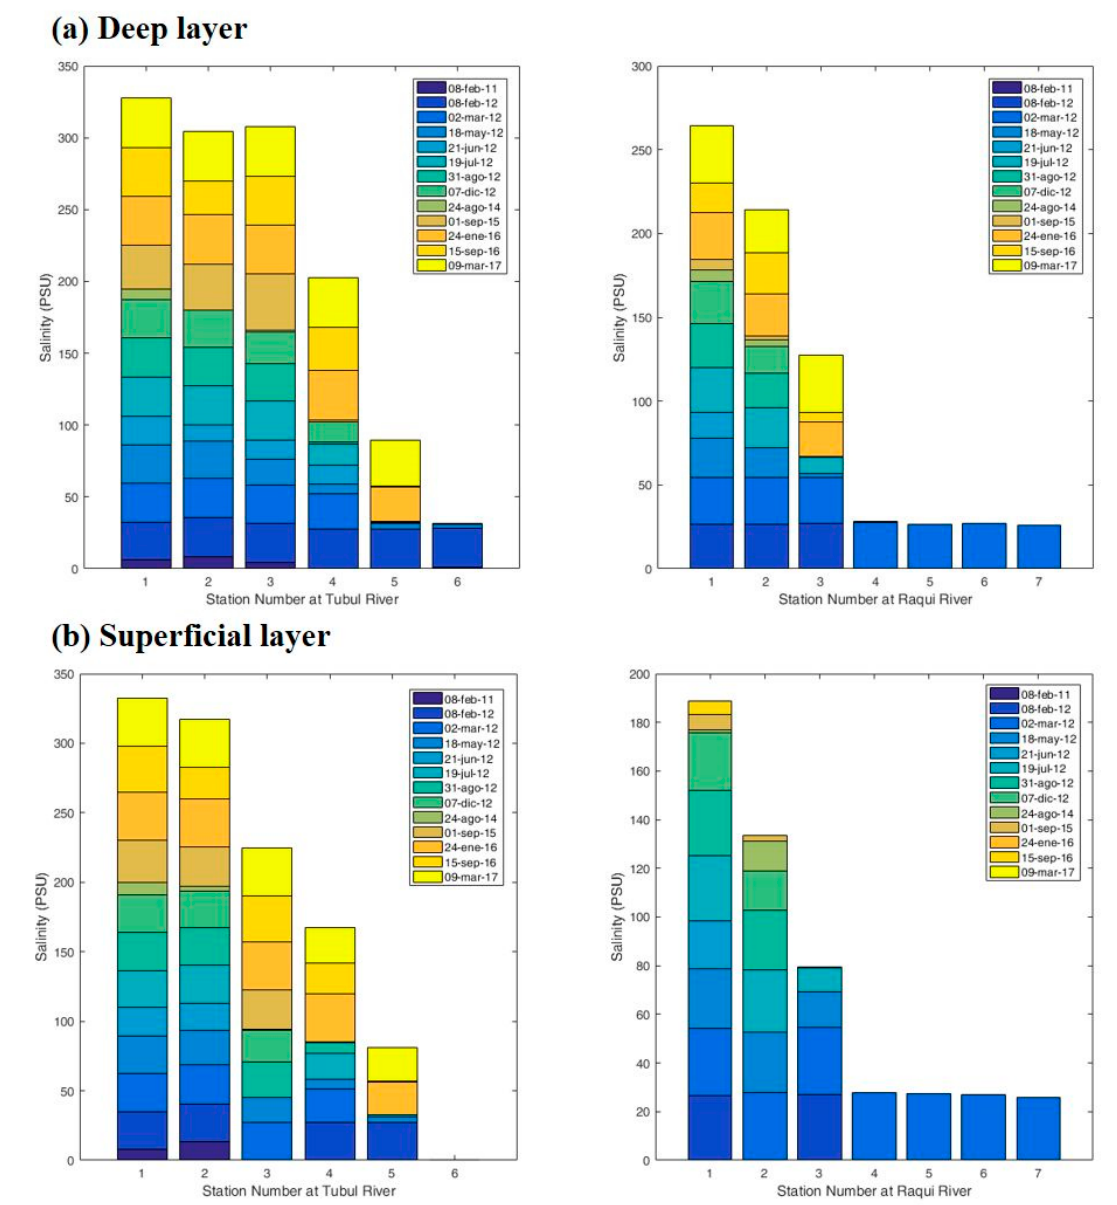
Figure 10. Salinity values (PSU) for postearthquake conditions, Tubul-Raqui wetland. Through the salinity values, shows how the coastal uplift altered the tidal wave intrusion into the interior of the estuary, where minimum values were recorded at most stations ( a , b ). Even so, this was a short-term effect because, by early 2012, salinity was instrumentally recorded 6 km upstream in the Tubul River. At stations with a water depth greater than 0.5 m (Raqui River and stations 3 to 7 in the Tubul River), a slight recovery of marine intrusion was observed over time.